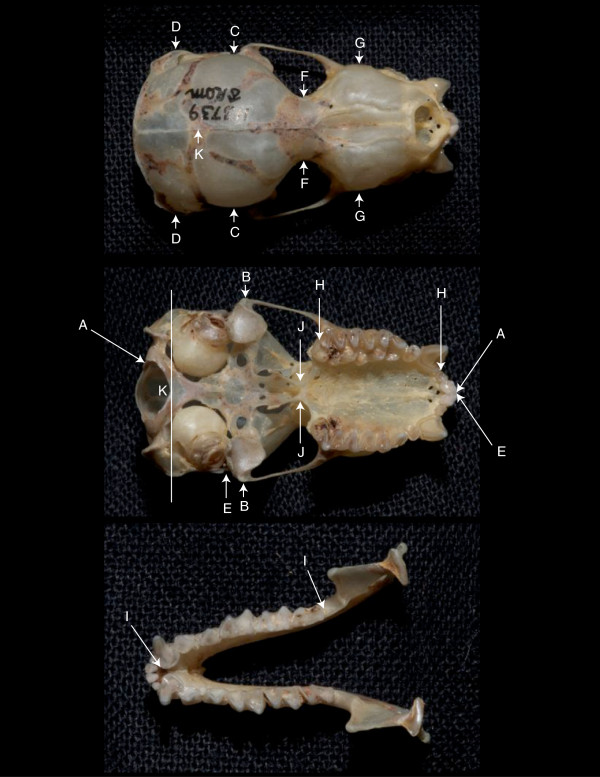
Eleven cranial measures used in morphometric analysis of Pteronotus parnellii following Smith [[53]]. The characters are: condylobasal length (A-A), zygomatic breadth (B-B), breadth of braincase (C-C), mastoid breadth (D-D), zygorostral length (E-E), interorbital breadth (F-F), rostral breadth (G-G), alveolar length of maxillary toothrow (H-H), alveolar length of mandibular toothrow (I-I), breadth of post-palatal extension (J-J), depth of braincase (K-K).